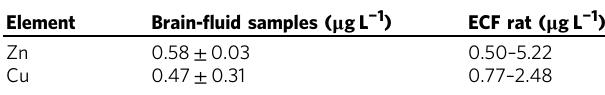
Table 1 Mean Zn and Cu concentration found in the 3 the brain- fl uid samples (mean ± SD). The values are compared to basal concentration level found in the ECF of rat